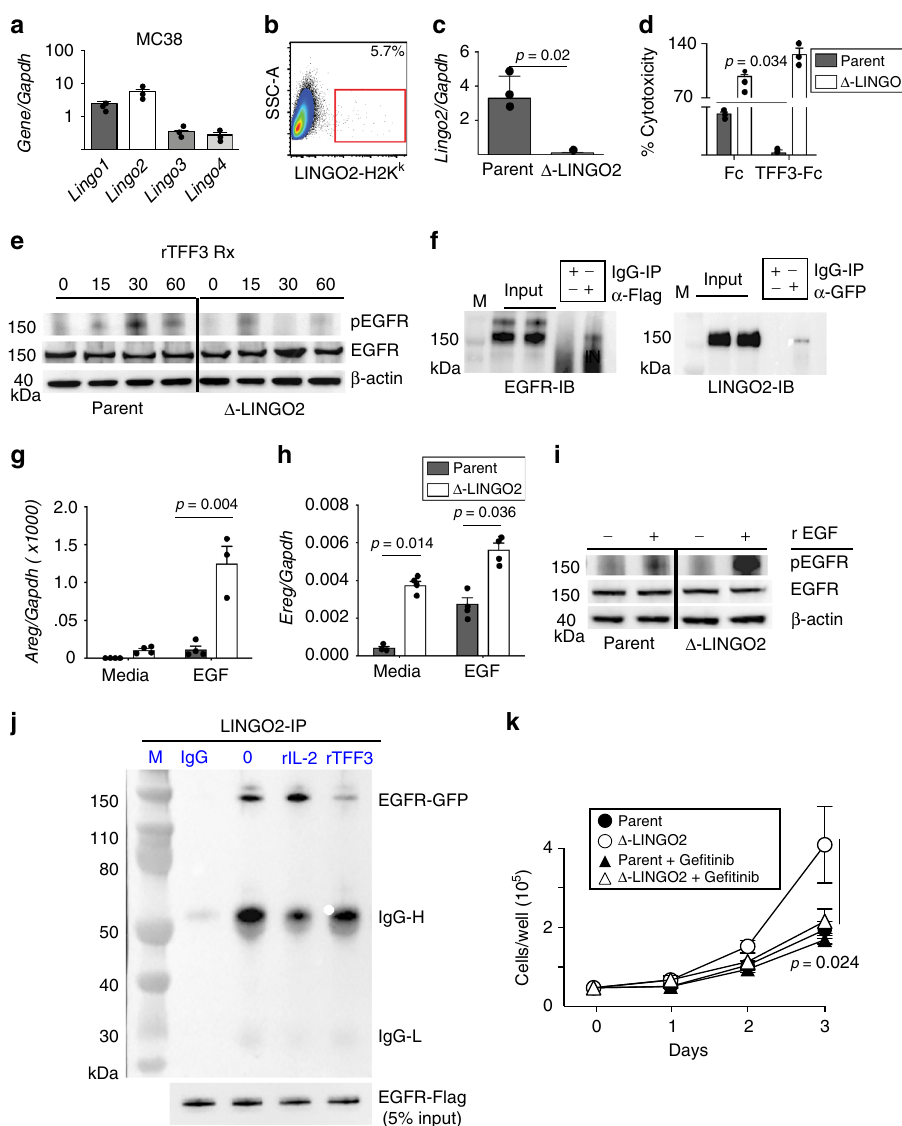
Fig. 2 TFF3 requires LINGO2 to block cytotoxicity, regulate STAT3 and de-repress EGFR activation. a LINGO family mRNA transcript levels in the MC38 mouse intestinal cell line. Mean ± SE of 3 – 6 replicates are shown. b Gating strategy for FACS-sorting based isolation of CRISPR/CAS9 gene-edited MC38 cells via incorporation of the LINGO2-H2-K K knock-in construct designated as “ Δ -LINGO2 ” c Lingo2 mRNA transcript levels in Δ -LINGO2 MC38 cells as determined by QRT-PCR. Mean± SE of triplicate wells. d Staurosporine-induced cytotoxicity at 6 h-post exposure of MC38 vs. Δ -LINGO2 cells following exposure to Fc (1 μ g/mL) or TFF3-Fc (1 μ g/mL or 23.81 nM) in DMEM 1% FBS. Mean± SE of triplicate wells. e Time-course of phospo-EGFR (Y-1068) vs. total EGFR levels compared to beta-actin loading control in MC38 vs. Δ -LINGO2 cells exposed to Fc vs. TFF3-Fc (1 μ g/mL). f Reciprocal co- immunoprecipitation of LINGO2-Flag and EGFR-GFP in co-transfected HEK293 cells. IP was performed with anti-Flag followed by IB with anti-GFP (left) or IP with anti-GFP followed by IB with anti-Flag (right). g mRNA expression levels of Amphiregulin ( Areg) and h Epiregulin (Ereg) compared to Gapdh in parental MC38 vs Δ -LINGO2 cells following exposure to either media alone or rEGF (1 μ g/mL) Mean± SE of triplicate wells shown. i Phospho-EGFR (Y- 1068) and total EGFR levels in parental MC38 vs Δ -LINGO2 at baseline or after stimulation with rEGF (1 μ g/mL). j Co-IP of LINGO2-Flag and EGFR-GFP complexes in the presence of media only, soluble rIL-2, or rTFF3. k Kinetic analysis of cellular turnover for parental MC38 vs. Δ -LINGO2 cells in the presence or absence of the EGFR inhibitor Ge fi tinib (5 μ M) treatment. Mean ± SE of six replicates are shown. Results of unpaired two-tailed t tests shown as p values in c , d , g , h and two-way ANOVa analyses in k 200 bp deletion immediately downstream of the transcriptional start site (Supplementary Fig. 3A). For initial characterization, their total vs. activated pEGFR levels under naive, steady-state intestinal tissues were subjected to LINGO2pAb immunostaining conditions. Colonic tissues from Lingo2 KO mice had no which revealed lack of LINGO2 on small intestinal villi in Lin- difference in colon length vs WT (Supplementary Fig. 3E), go2 KO mice compared to WT C57BL/6 controls and isotype but higher basal levels of pEGFR compared to WT tissue matched Ab (Supplementary Fig. 3B – D). (Fig. 3a). Consistent with enhanced EGFR activity, despite macroscopically similar appearing colonic crypts and colon suppressed EGFR, whole colonic tissues were isolated from WT lengths (Fig. 3b), quanti fi cation of S-phase crypt epithelial cells NATURE COMMUNICATIONS| (2019) 10:4408